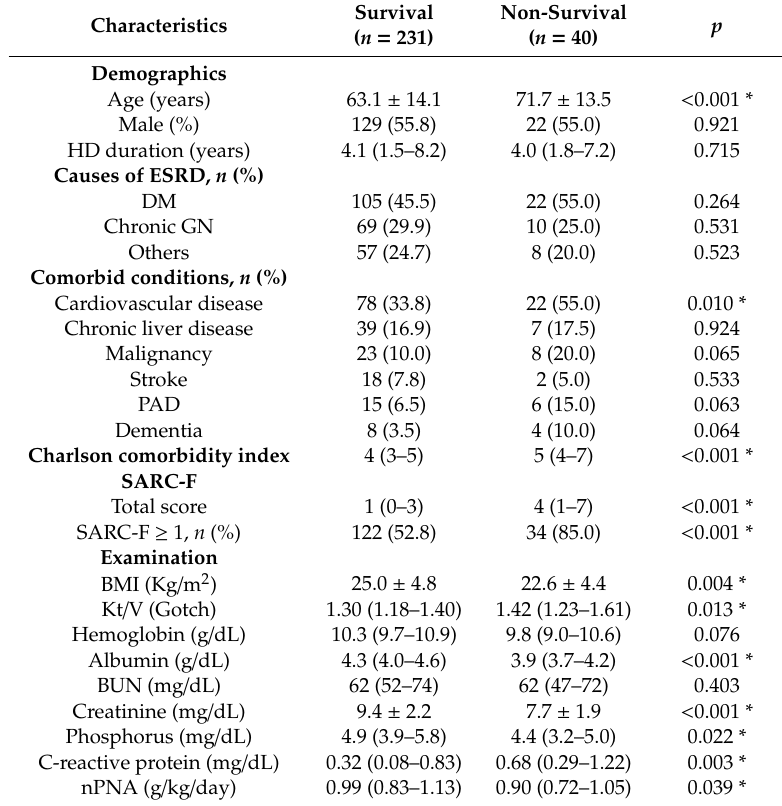
Table 4. Comparison between clinical characteristics of survival and non-survival patients.